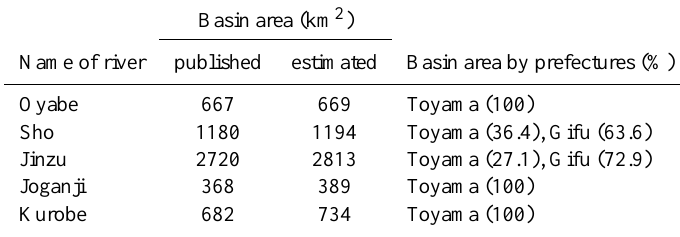
Table 1. Published and estimated river basin area of the five rivers in Toyama Prefecture.